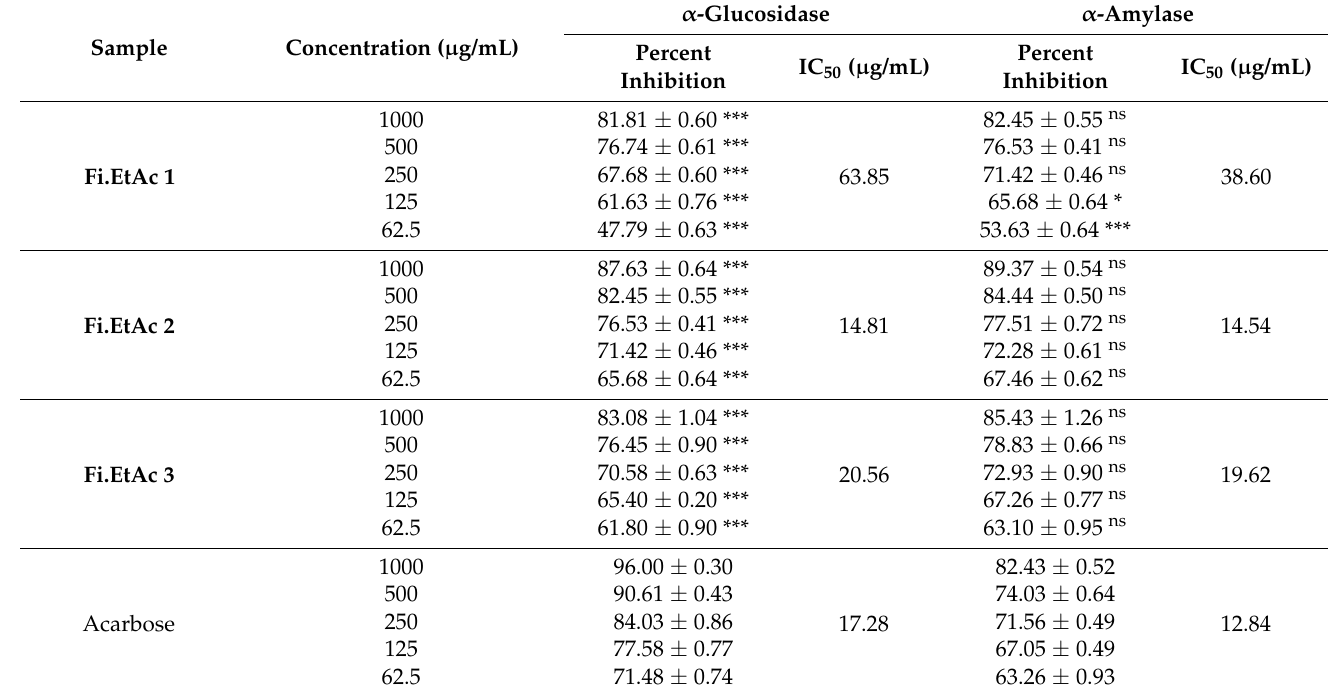
Table 3. α -Glucosidase and α -amylase results of semi-purified ethyl acetate fraction of Fragaria indica .